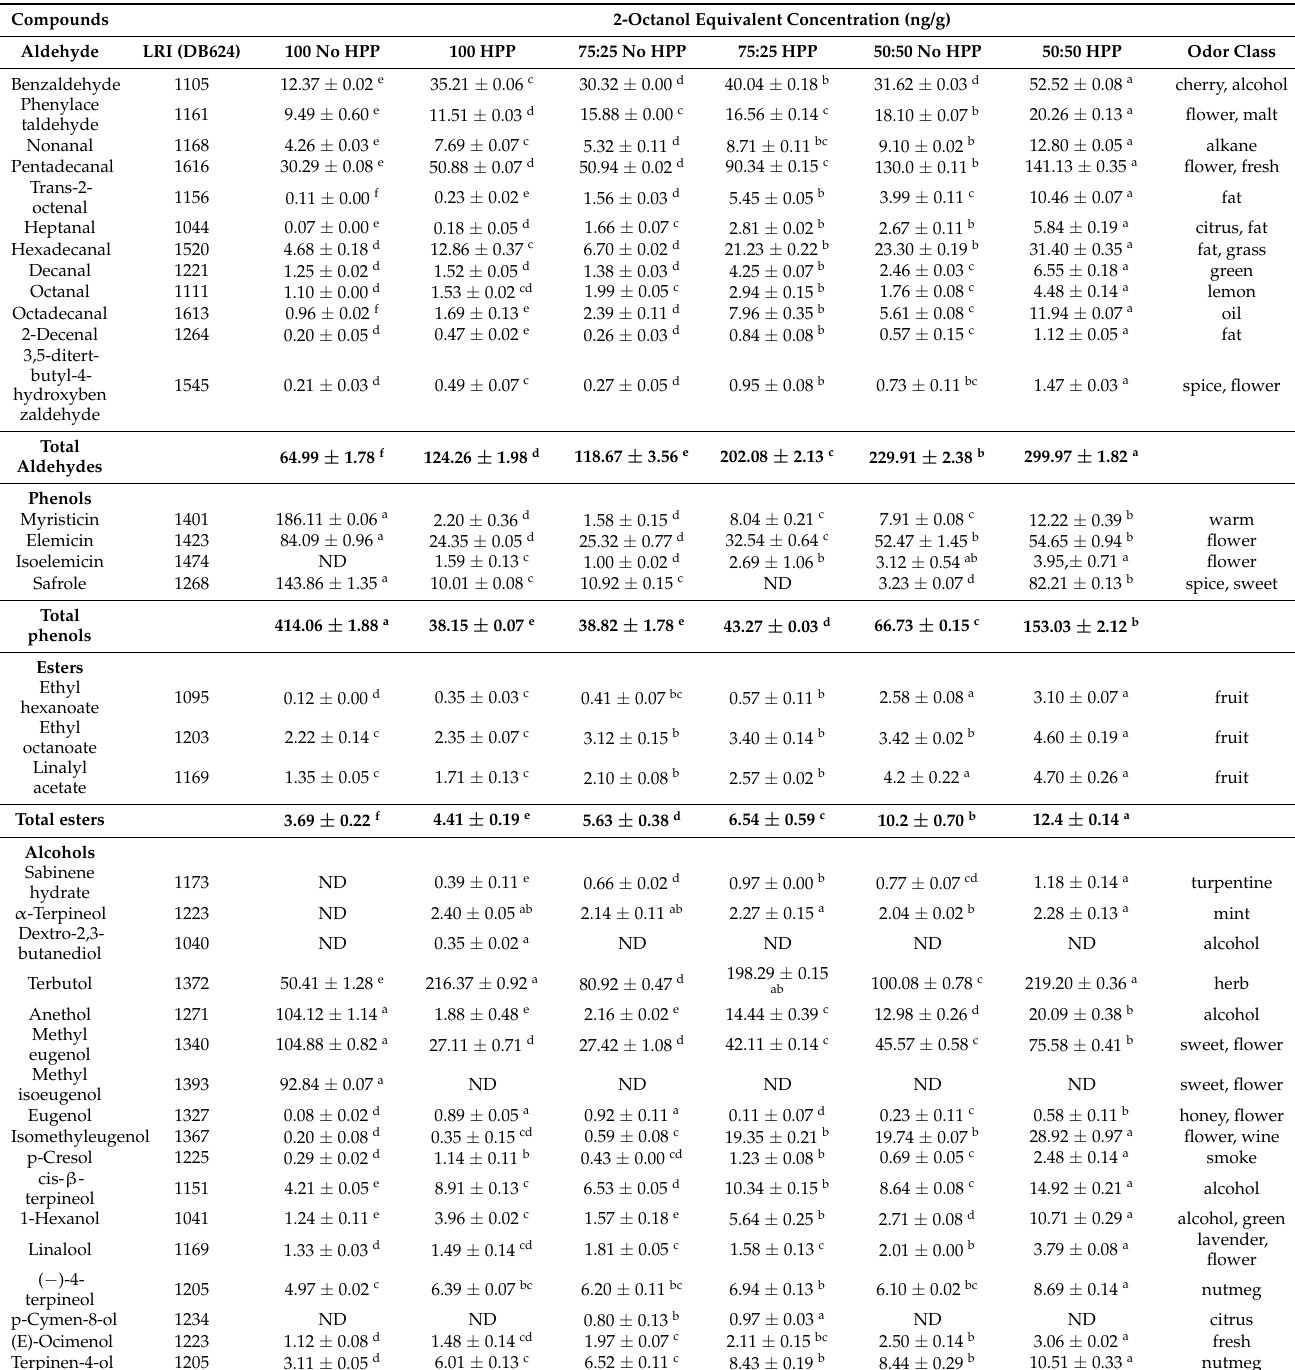
Table 3. Volatile compounds identified in beef sausage subjected to NaCl partial replacement with KCl coupled with high-pressure processing (HPP) under cold